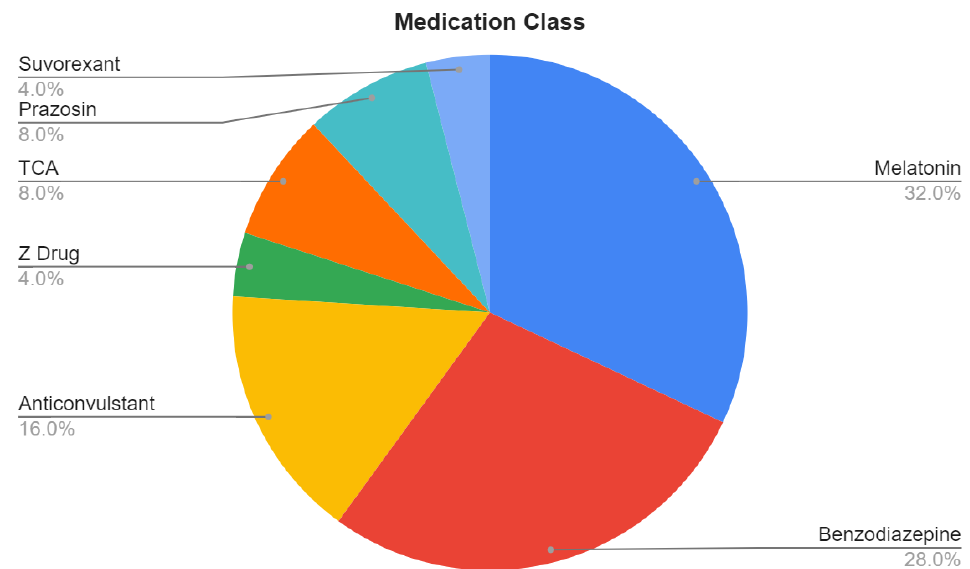
Figure 2. Proportions of medications taken by subjects.